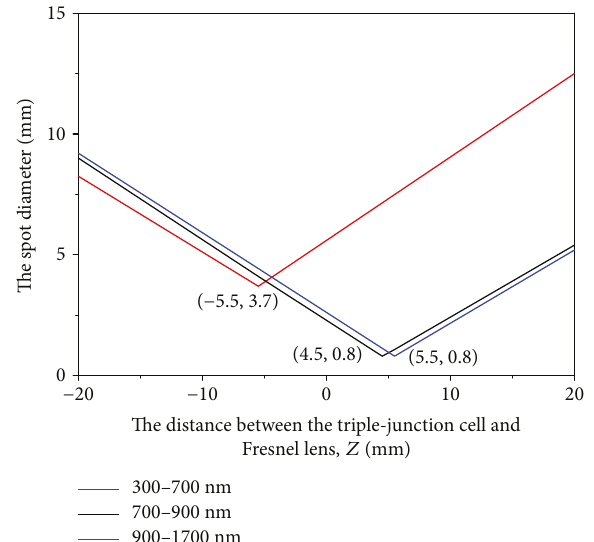
Figure 8: The variation of the spot diameter of three bands with the position of the optical axis under Fresnel